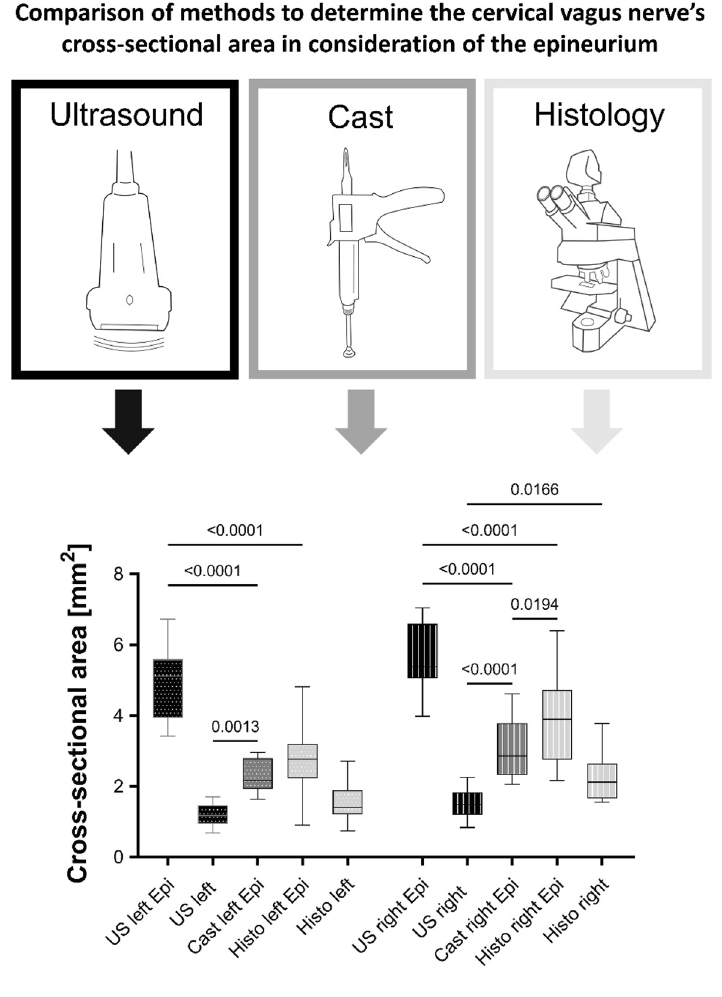
Figure 3. Box plots comparing different methods to determine the cervical vagus nerve’s cross-sectional area in consideration of the epineurium. Dotted Boxes indicate the left side, striped boxes the right side. The boxes show the 25th, 50th and 75th percentile, whiskers the minima and maxima. The solid line marks the median. Black—ultrasound (US), darker grey—cast, lighter grey—histology (Histo); Epi: Measurements contain the